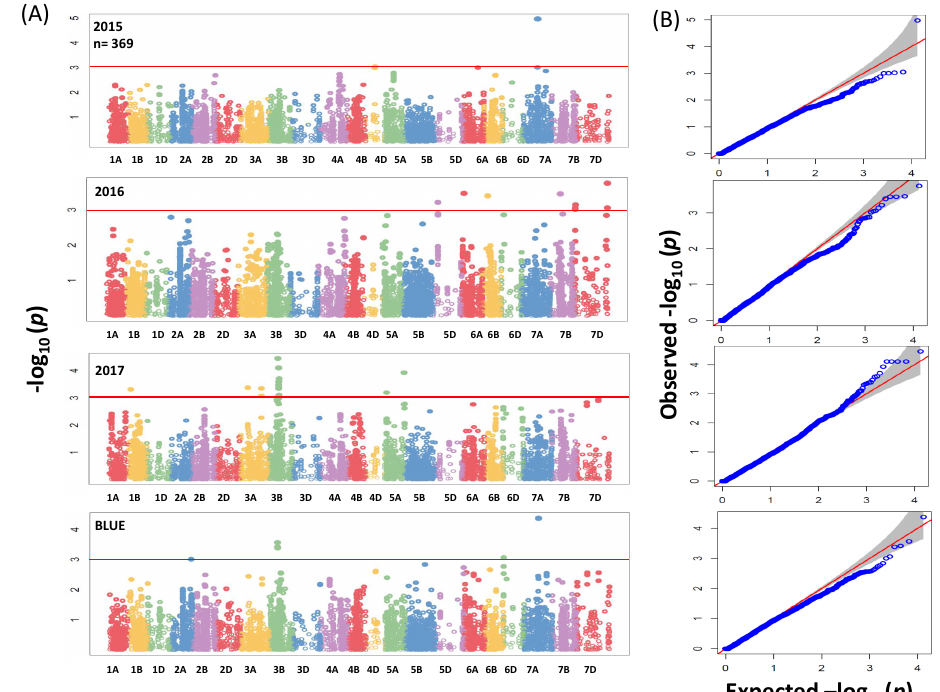
Figure 4. ( A ) Summary of genome-wide association scans for the whole panel of wheat genotypes (369) which were analyzed by using the 90K iSELECT Infinium array and the 35K Affymetrix SNP array for each year (2015/2016/2017) and BLUEs. The horizontal red color line indicated the threshold of − log 10 ( p -value) of 3. ( B ) Quantile-quantile scale representing expected versus observed − log 10 ( p